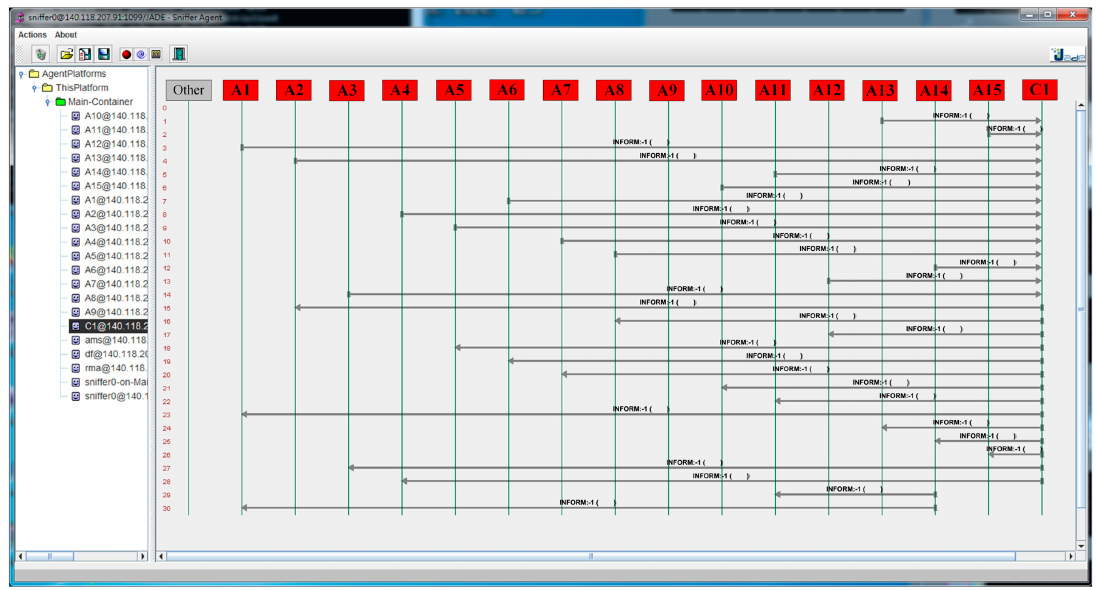
Figure 18. Interactive communication of the agents under islanded mode and fault occurrence at Bus 2.